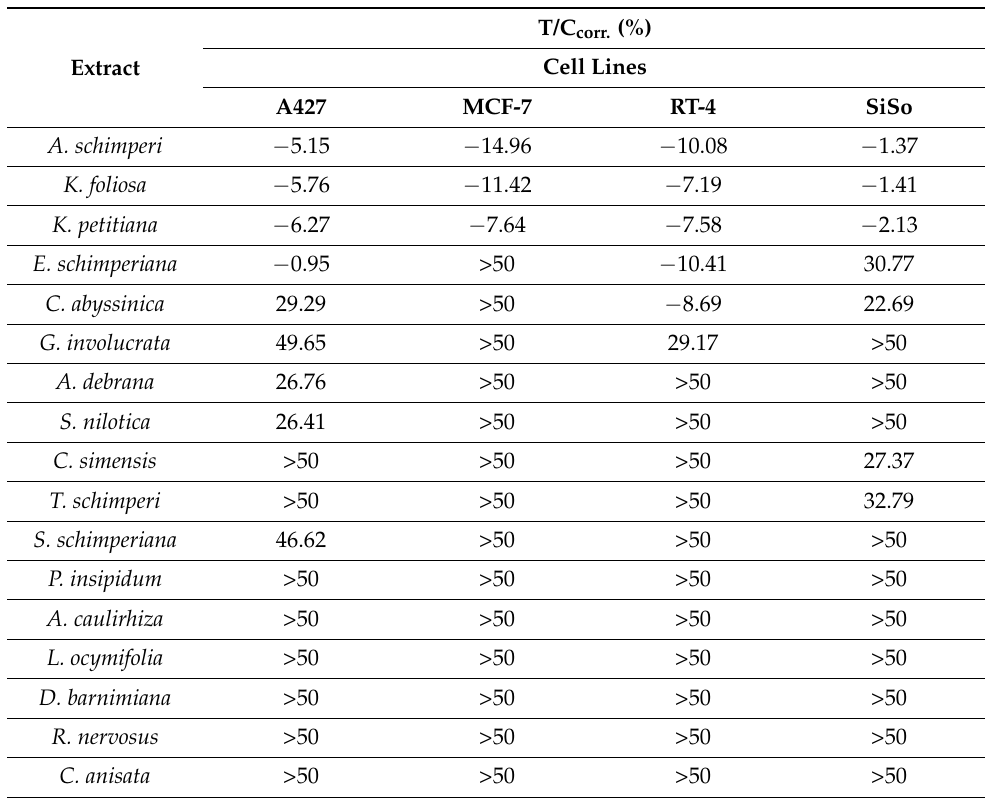
Table 1. Cytotoxic activity T/C corr (%) of extracts (50 µ g/mL) after 96 h on MCF-7, A427, RT- 4, and SiSo cell lines in primary screening. Testing was conducted with the crystal violet cell proliferation